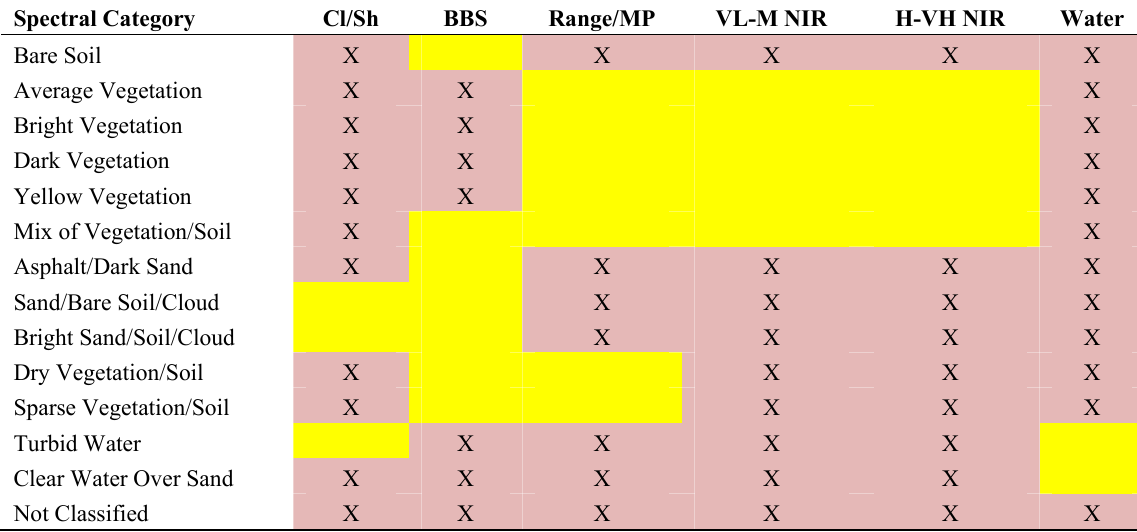
Table 9. Coarse-granularity S-SIAM™ pre-classification of the IRS test image.